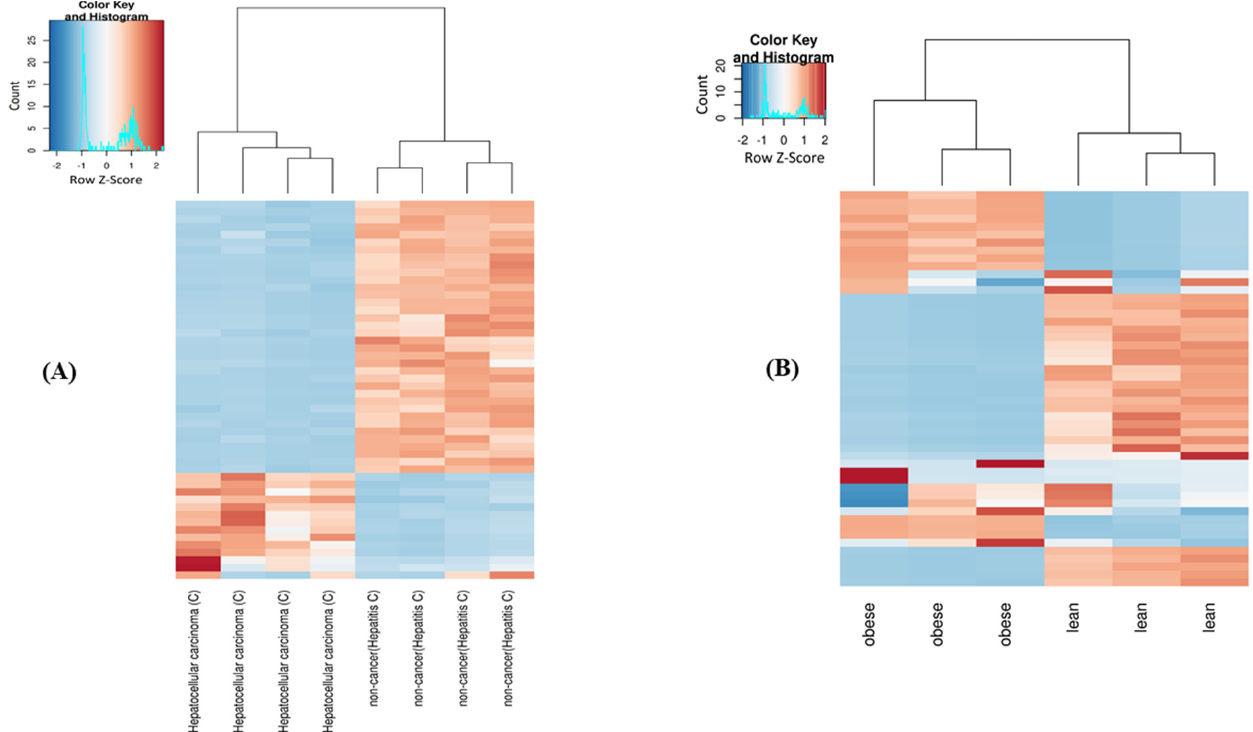
Figure 1. Clustering of the top-50 highly variable small mt-ncRNAs in the dataset-1 ( A ) and dataset-2 ( B ). Table 1. Differentially expressed (DE) mt-sRNAs ( p -adj < 0.1) in pairwise comparisons of datasets generated by [18] (dataset-1). Liver samples ( n = 4 for each group) were obtained from subjects suffering chronic hepatitis C (HC) or hepatitis B (HB), with either diagnosed hepatocellular carci- noma or non-malignant tissue, as well as from uninfected subjects with hepatocellular carcinoma. Arrows show significantly ( p -adj < 0.1) up-or down-regulated mt-sRNAs.